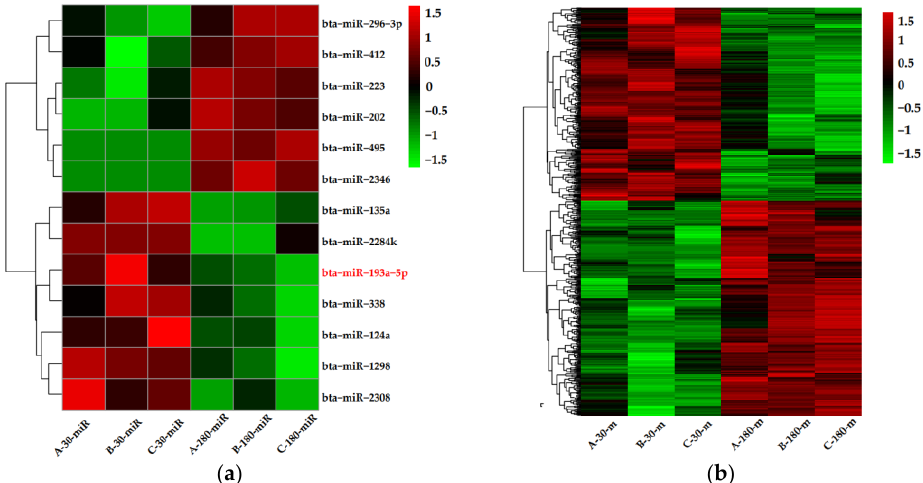
Figure 2. Heat maps of differentially expressed microRNAs (DE miRNAs) and genes (DEGs) in dairy cow mammary glands between early and mid-lactation. ( a ) Red modules represent upregulated DE miRNAs, and green modules represent downregulated DE miRNAs. ( b ) Red modules represent upregulated DEGs, and green modules represent downregulated DEGs.